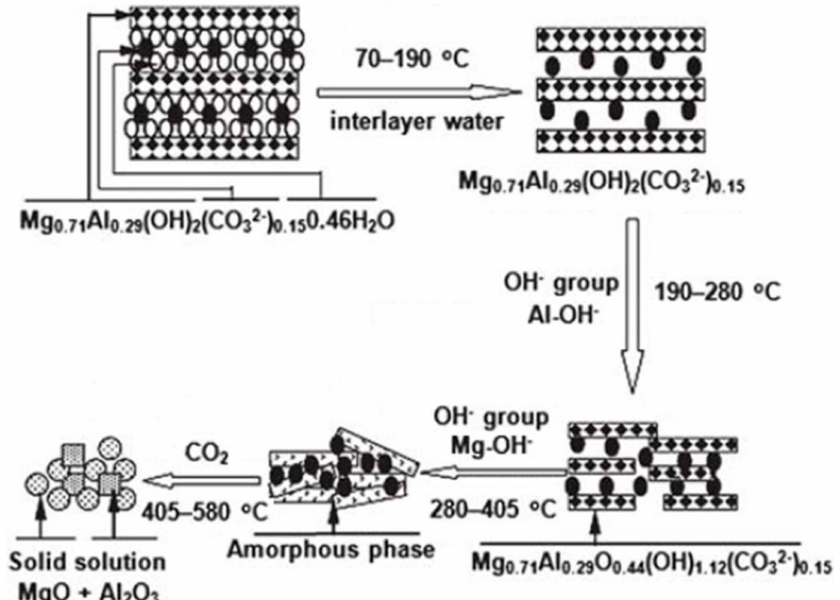
Figure 13. The structural evolution of a typical HTC as a function of calcination temperature. Adapted with permission from Ref. [275]. Copyright 2021 Royal Society of